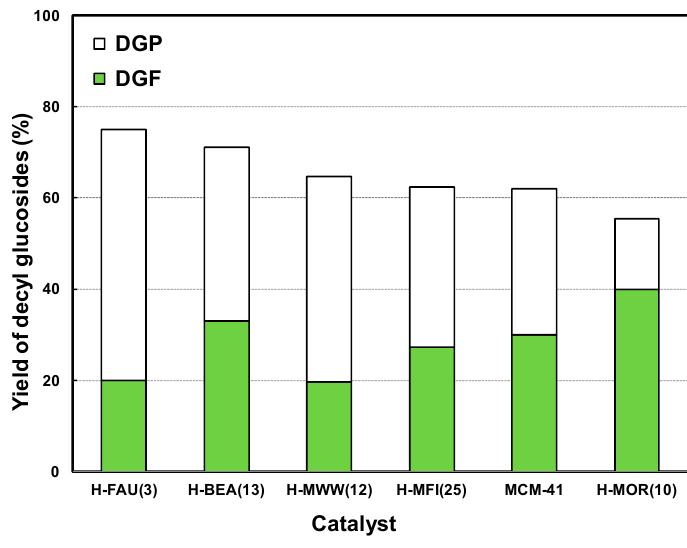
Figure 6. Yields of decyl glucosides on various zeolite catalysts at 130 °C after a process time of 4 h.